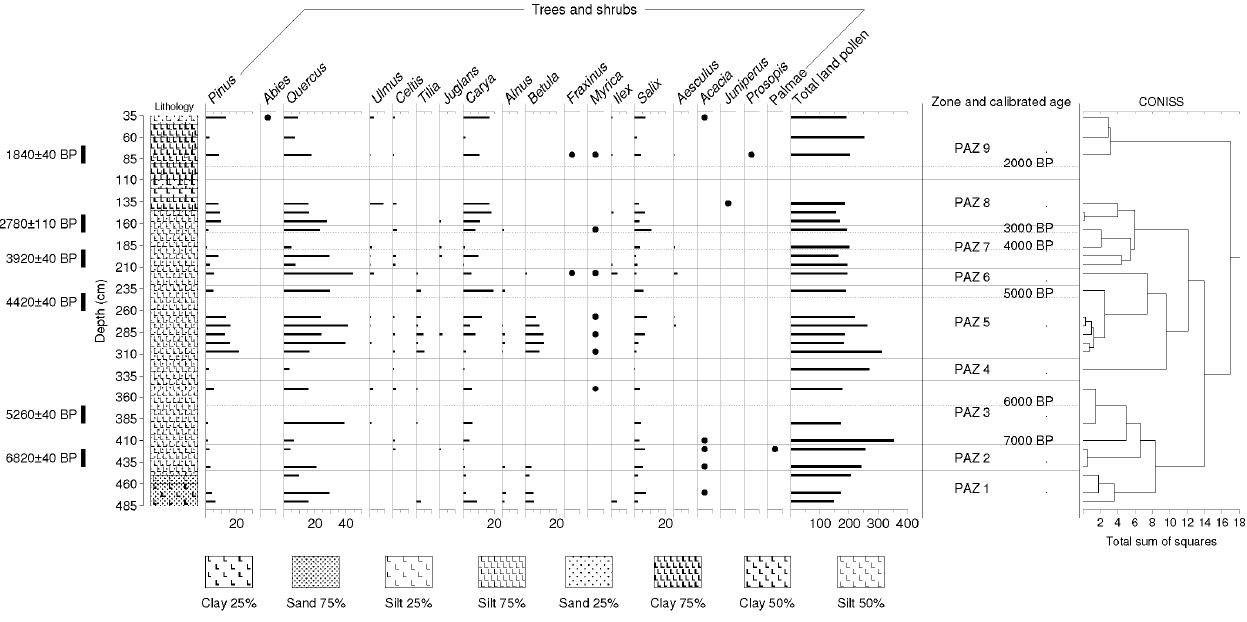
Figure 4. Buckeye Knoll (BK) relative pollen diagram (arboreal pollen as percentage of TLP) and Troels-Smith lithology. Note redox (red coloration) features.